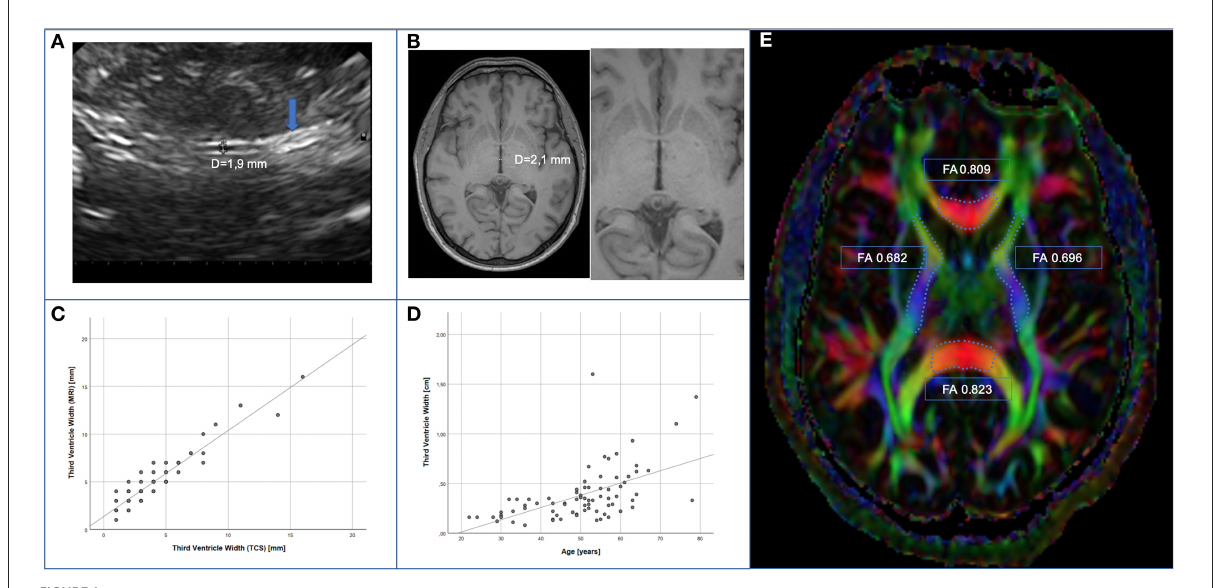
FIGURE1 Measurement of WTV. (A) Example of sonographic measurement of third ventricle width after identification of the pineal gland (arrow). (B) Example of measurement of third ventricle width in axial plane by MRI. (C) Correlation of TCS- vs. MRI-based assessment (spearman r = 0.884; p < 0.001). (D) Correlation of TCS based assessment and age (spearman r = 0.546; p < 0.001). (E) illustrative example of FA-measurement of corpus callosum (genu and splenium) and capsulae internae on both sides.